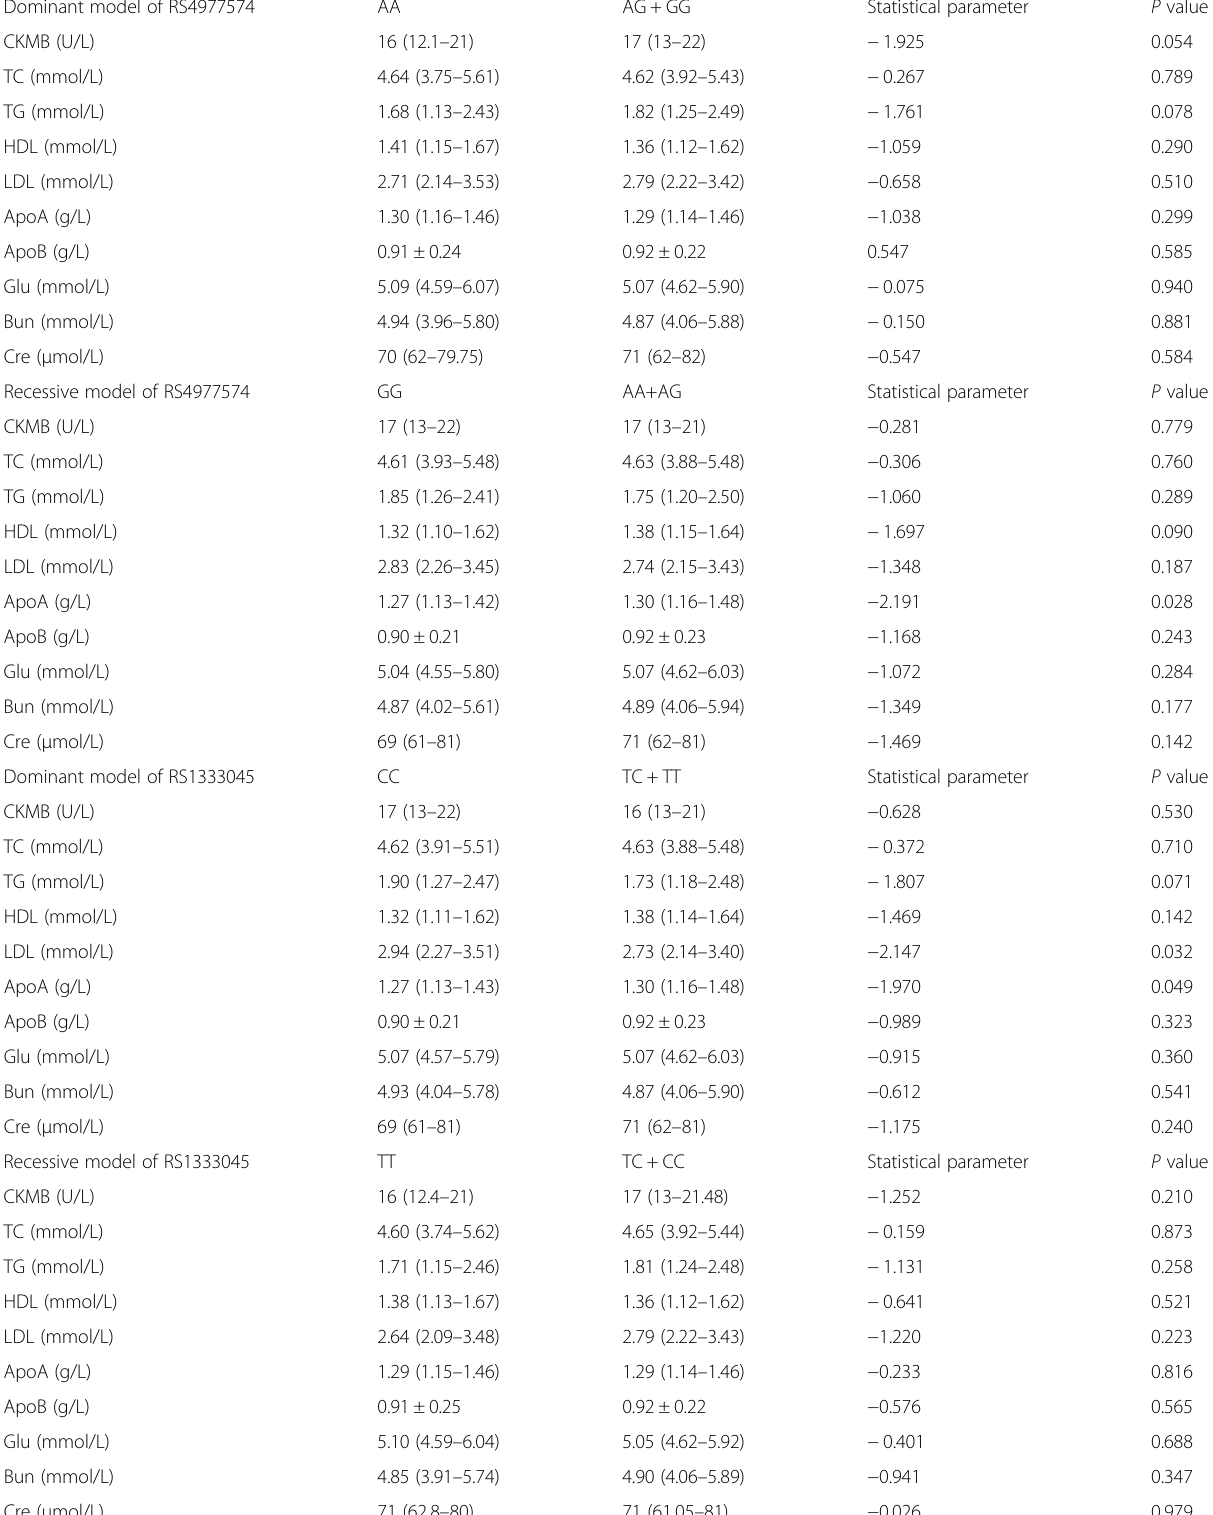
Table 3 Comparisons of serological biomarkers in the dominant model and recessive